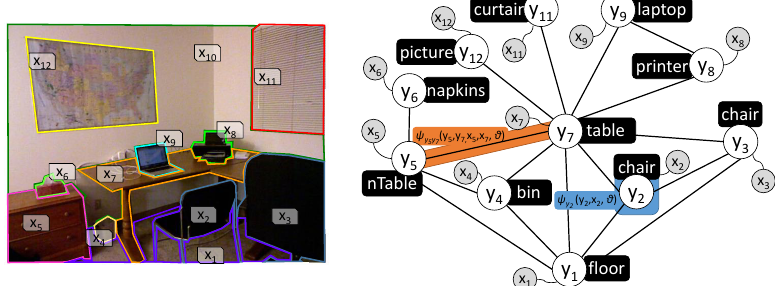
Figure 7. ( Left ) Scene from the NYUv2 dataset with segmented patches and their ids ( x 1 . . . x 12 ). ( Right ) Conditional Random Field (CRF) graph built according to the patches in the NYUv2 scene (the node and relations of the wall, x 10 , have been omitted for clarity). The orange area illustrates the scope of a pairwise factor modeling the relations between two objects, while the blue one stands for the scope of a unary factor classifying an object according to its features. Black boxes represent the expected results from a probabilistic inference process over such CRF.